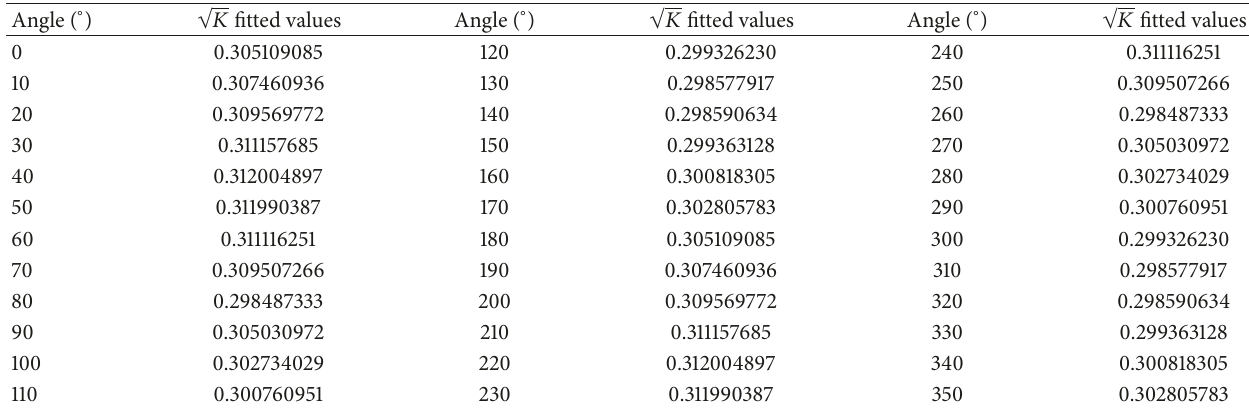
Table 3: Geometry parameters of the simulation